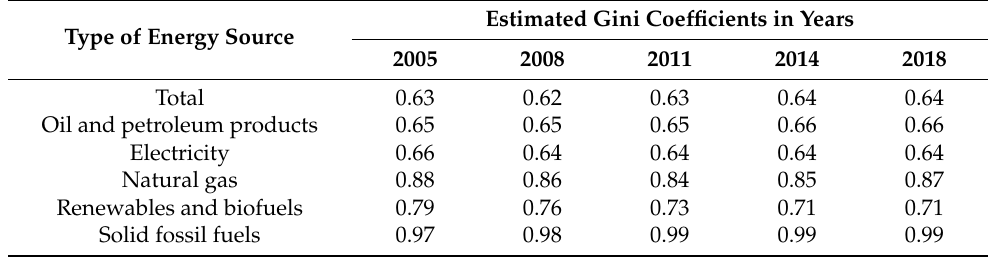
Figure 6. Lorenz concentration curves for the types of energy used in agriculture in the EU countries in 2018. Table 1. Estimated Gini coefficients for the types of energy used in agriculture in the EU countries in 2005–2018. Type of Energy Source